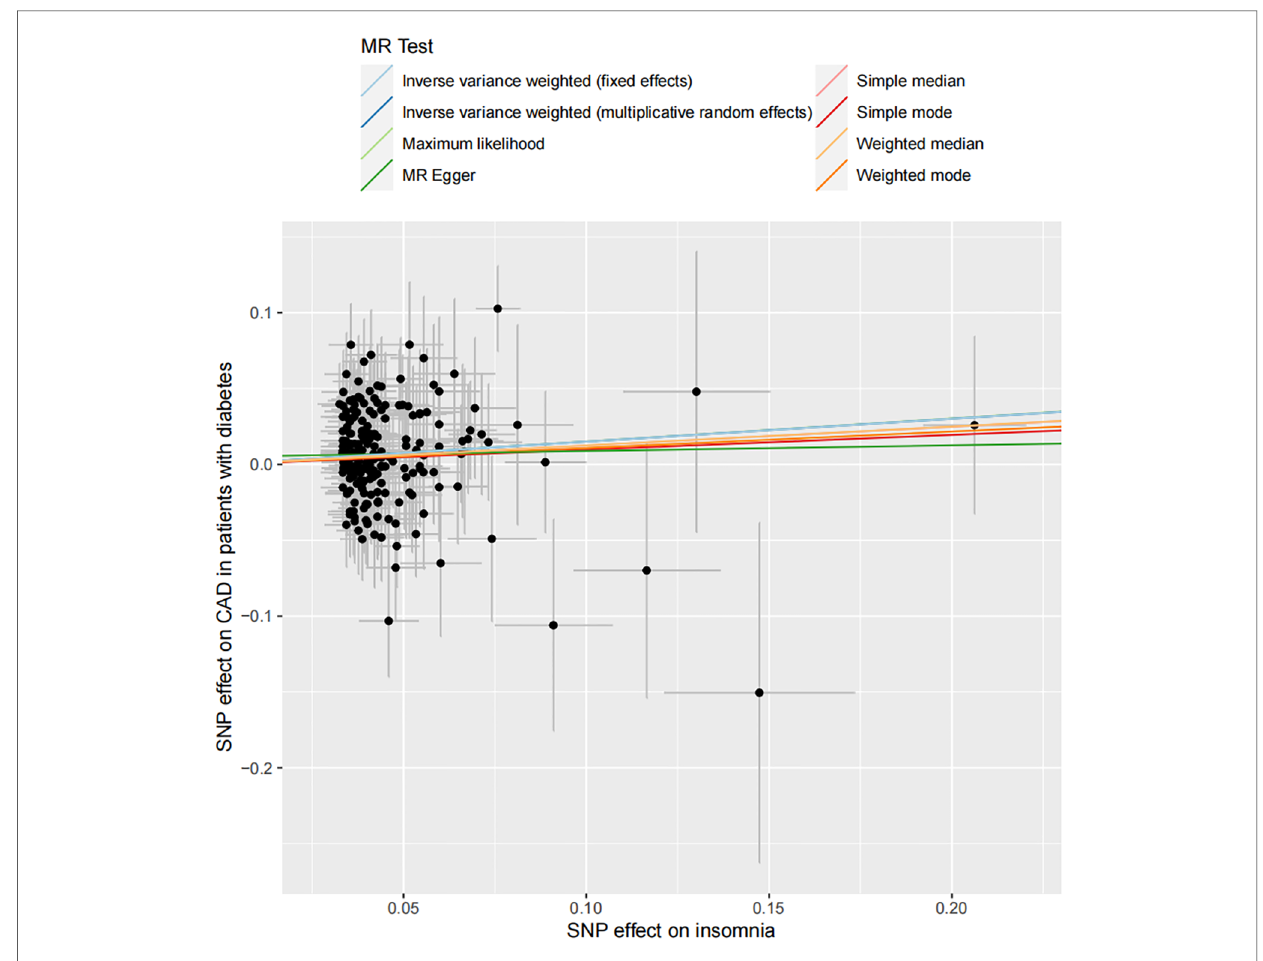
FIGURE 3 Scatter plot of the association between insomnia and the risk of CAD in patients with diabetes. Each dot indicates a SNP; each line indicates the estimate of association between insomnia and the risk of CAD in patients with diabetes using corresponding